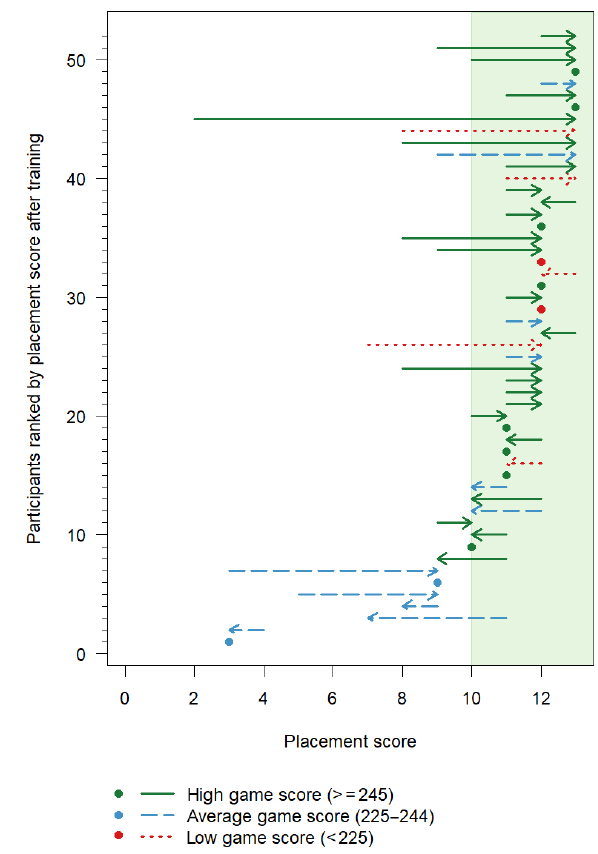
Figure 8. Placement scores before and after the training ( x axis) per participant ( y axis). Arrows point to scores from before to af- ter training. Dots indicate no change in the placement score and are coloured according to the game score they obtained during the training.